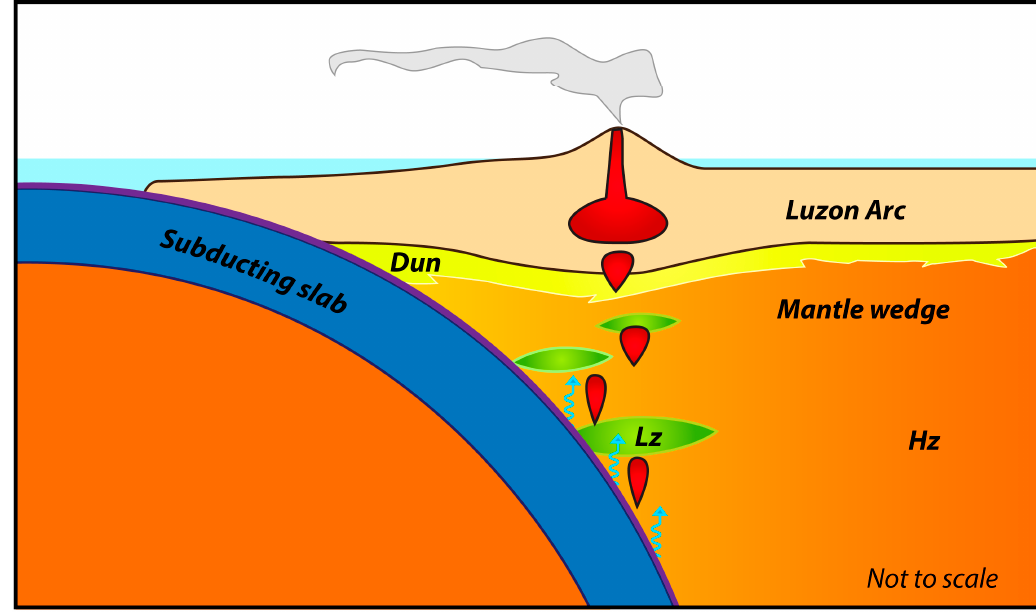
Figure 8. Diagram depicting the origin of the Mt. Pinatubo spinel peridotite xenoliths. Spinel lherzolite were converted to spinel harzburgite due to infiltration of fluids and partial melting in the mantle wedge. Lz = spinel lherzolite, Hz = spinel harzburgite and Dun = dunite.